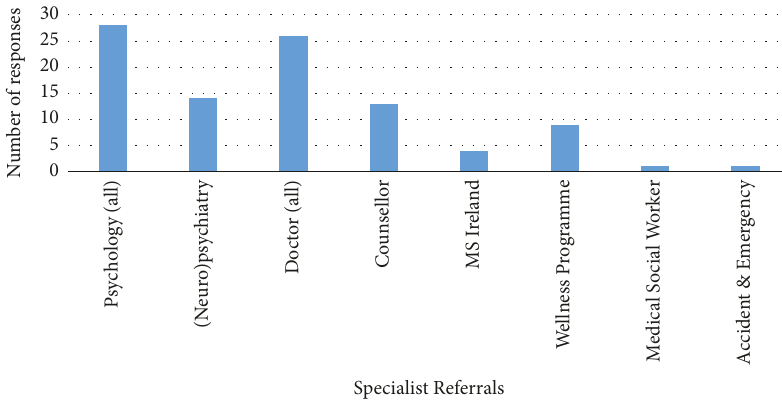
Figure 6: Specialists referred to by participants when mood difficulties were identified in people with MS.